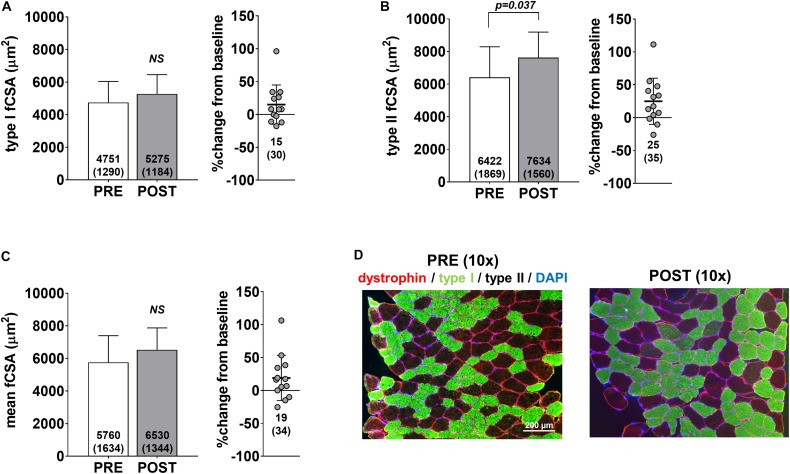
fCSA adaptations to high-load training. PRE to POST values for type I fCSA (A), type II fCSA (B), and mean fCSA (C). Panel D contains 10× representative PRE and POST images from a participant (scale bar = 200 μm).